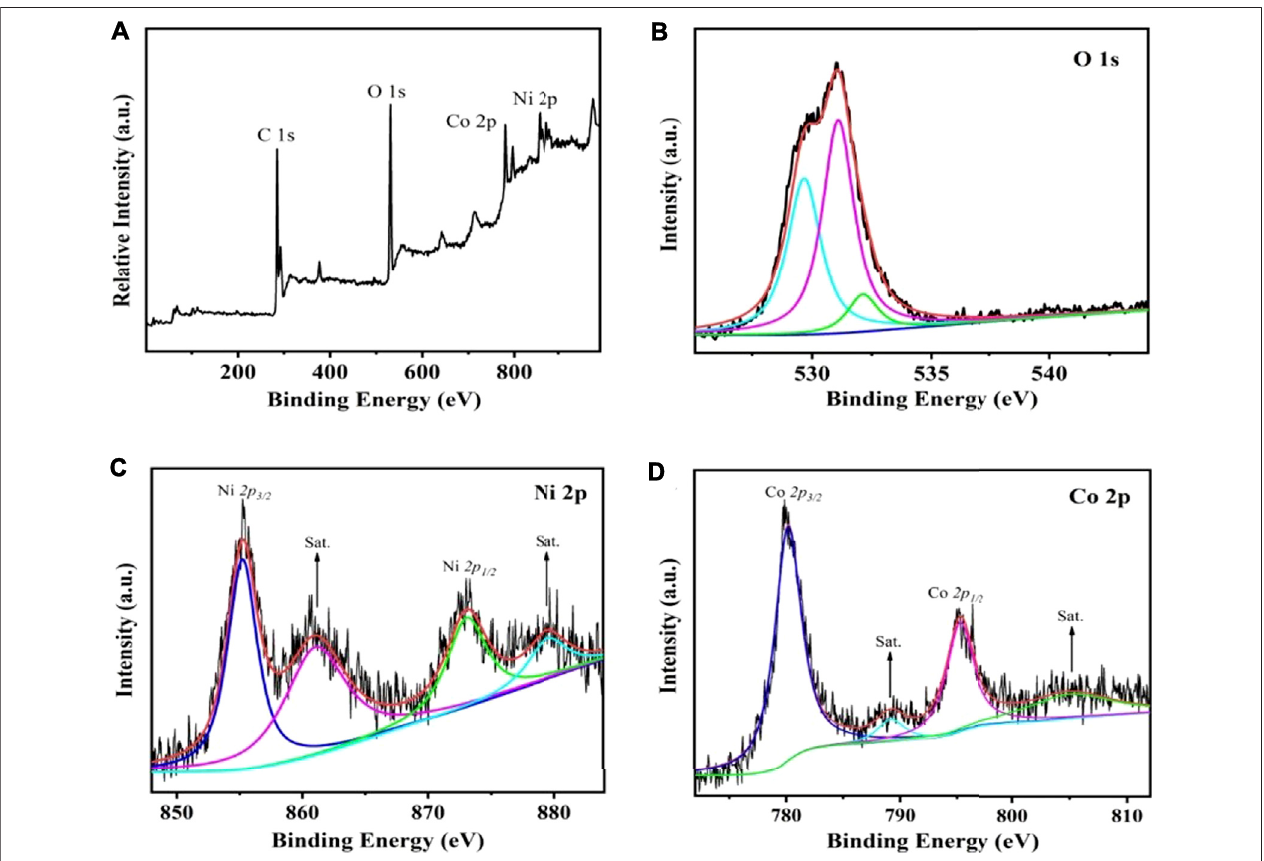
FIGURE5| TheXPSbandsforconvertedCoNi2hydroxide/CNTpapercompositeelectrodefullserve (A) andhighresolutiondataforO1s (B) ,Ni2p (C) ,Co2p (D) .